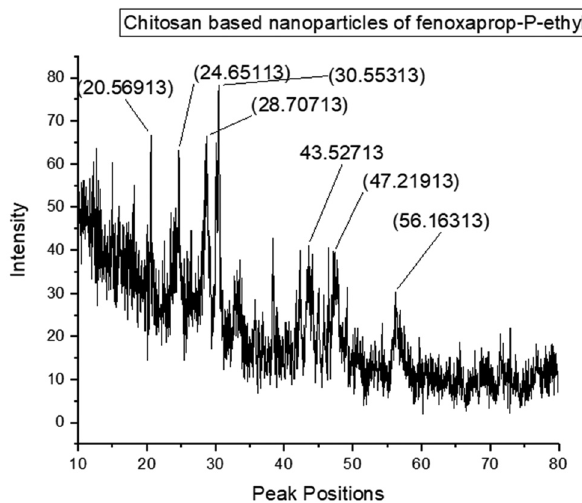
Figure 8: XRD analyses of chitosan - based NPs of fenoxaprop - p -